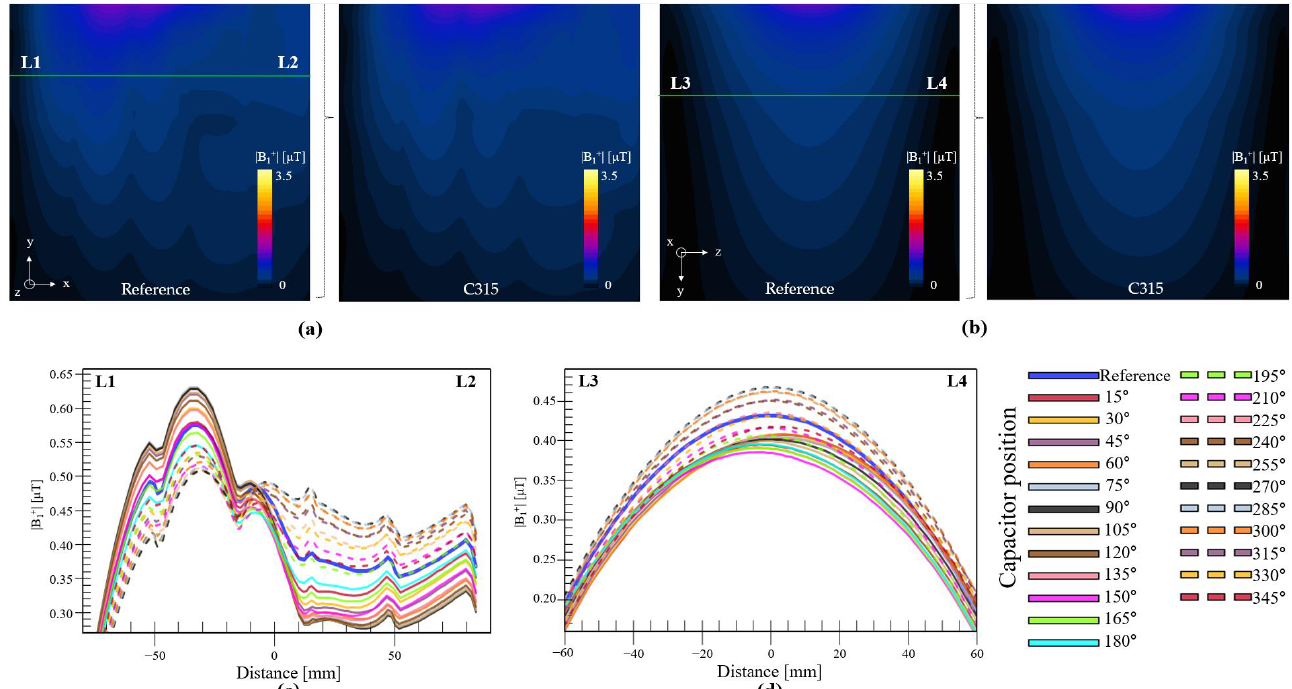
Figure 7. Computed |B 1+ | field inside phantom in XY plane for ( a ) the reference coil and the coil with capacitor at 315°. The field in view in the YZ plane ( b ) for the reference coil, and coil with capacitor at 315. ( c ) L1 – L2 line profile and ( d ) L3 – L4 line profile.